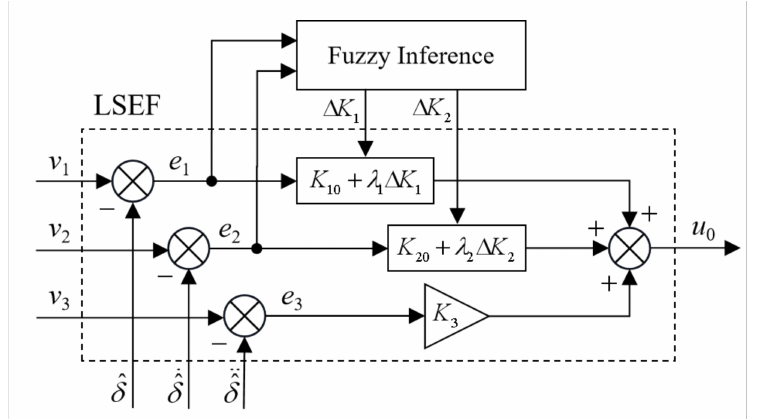
Figure 5. Diagram of the fuzzy LSEF.